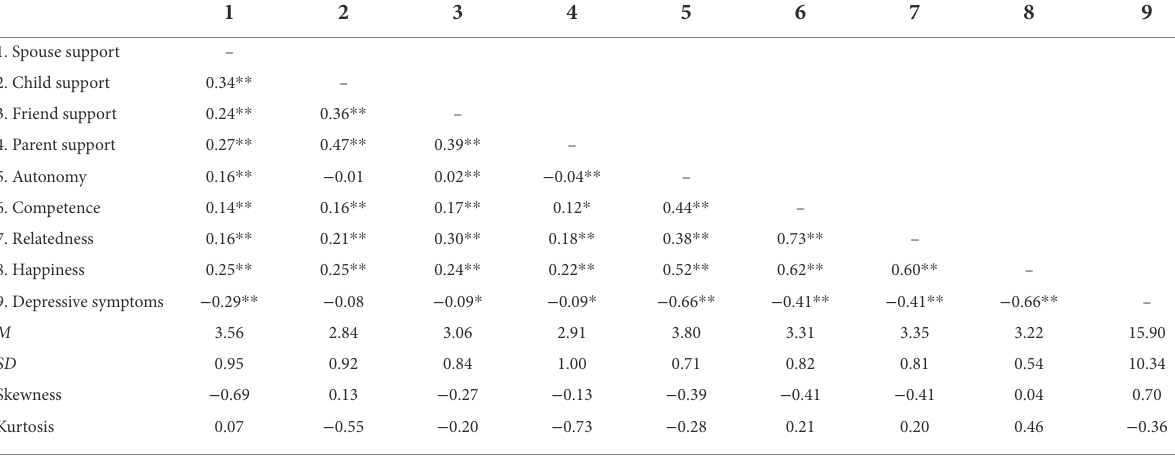
TABLE 2 The Pearson correlations and descriptive statistics for all research variables.